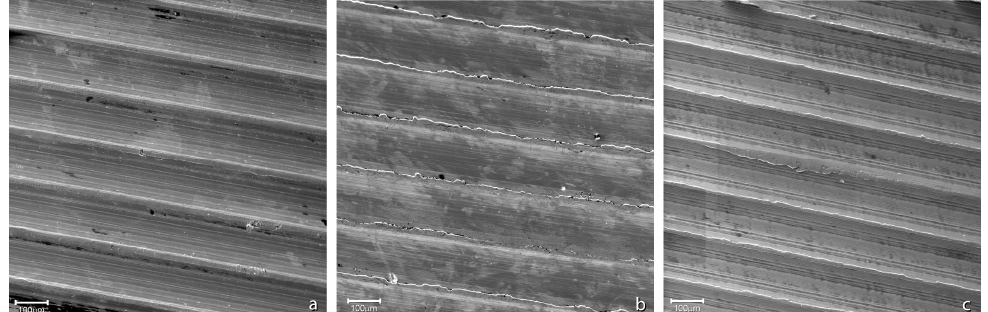
Figure 3. SEM images of tapers’ surfaces (magnification: 250×, working distance: 14 mm; accelerating voltage: 20.00 kV): ( a ) taper of Group 1; ( b ) taper of Group 2; ( c ) taper of Group 3.